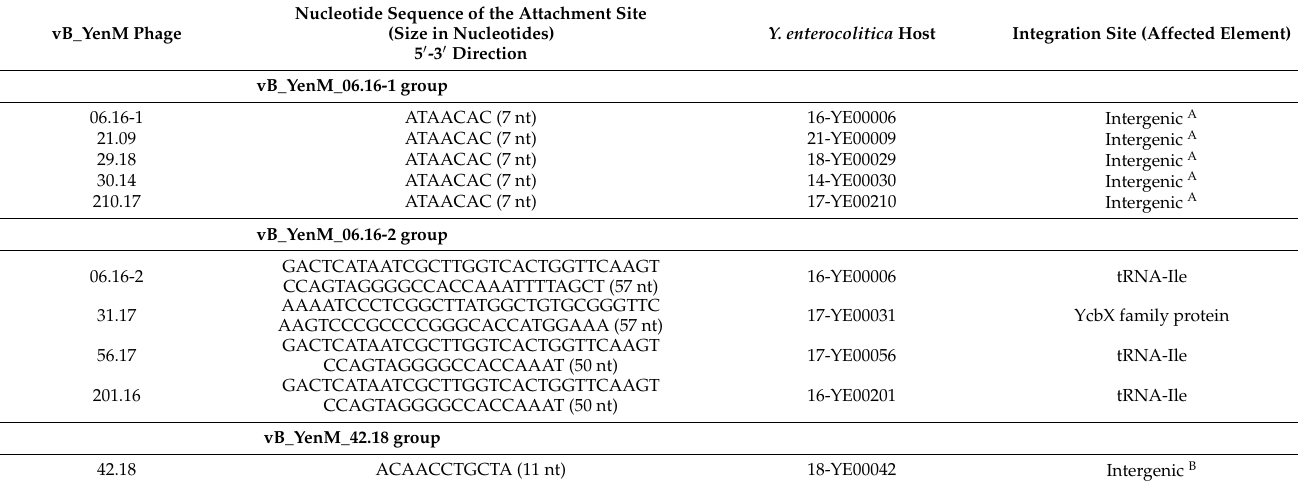
A intergenic sequence between genes coding for the pyridoxal phosphate-dependent aminotransferase and the methylthioribulose 1-phosphate dehydratase. B intergenic sequence between genes coding for a metalloprotease and a ribosome-associated